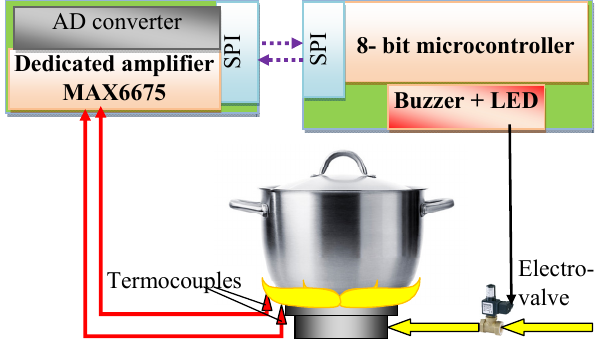
Figure 20. Scheme of the electronic controller.